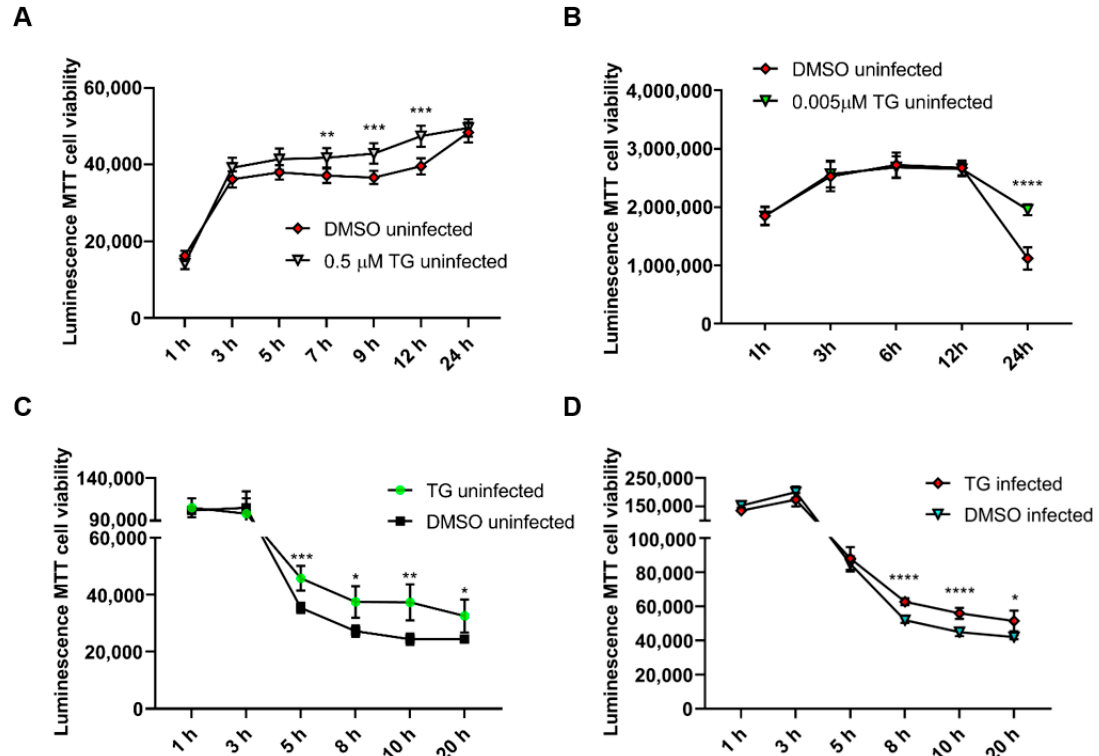
Figure 3. Continuous exposure of uninfected cells to antiviral doses of TG does not affect cell viability. Cell viability of ( A ) NPTr cells continuously incubated in the presence of 0.5 µM TG and ( B ) NHBE cells continuously incubated with 5 nM TG was monitored over 24 h with RealTime-Glo™ MT Cell Viability Assay. Readings indicate duration of TG exposure. Significance based on mixed effect analysis relative to corresponding DMSO control. Cell viability of ( C ) uninfected NPTr cells and ( D ) NPTr cells infected with 0.5 MOI USSR H1N1, pre-primed with 0.5 µM TG for 30 min, was monitored with RealTime-Glo™ MT Cell Viability Assay. Readings indicate duration of post mock or influenza virus infection. Significance based on mixed effect analysis relative to corresponding DMSO control.